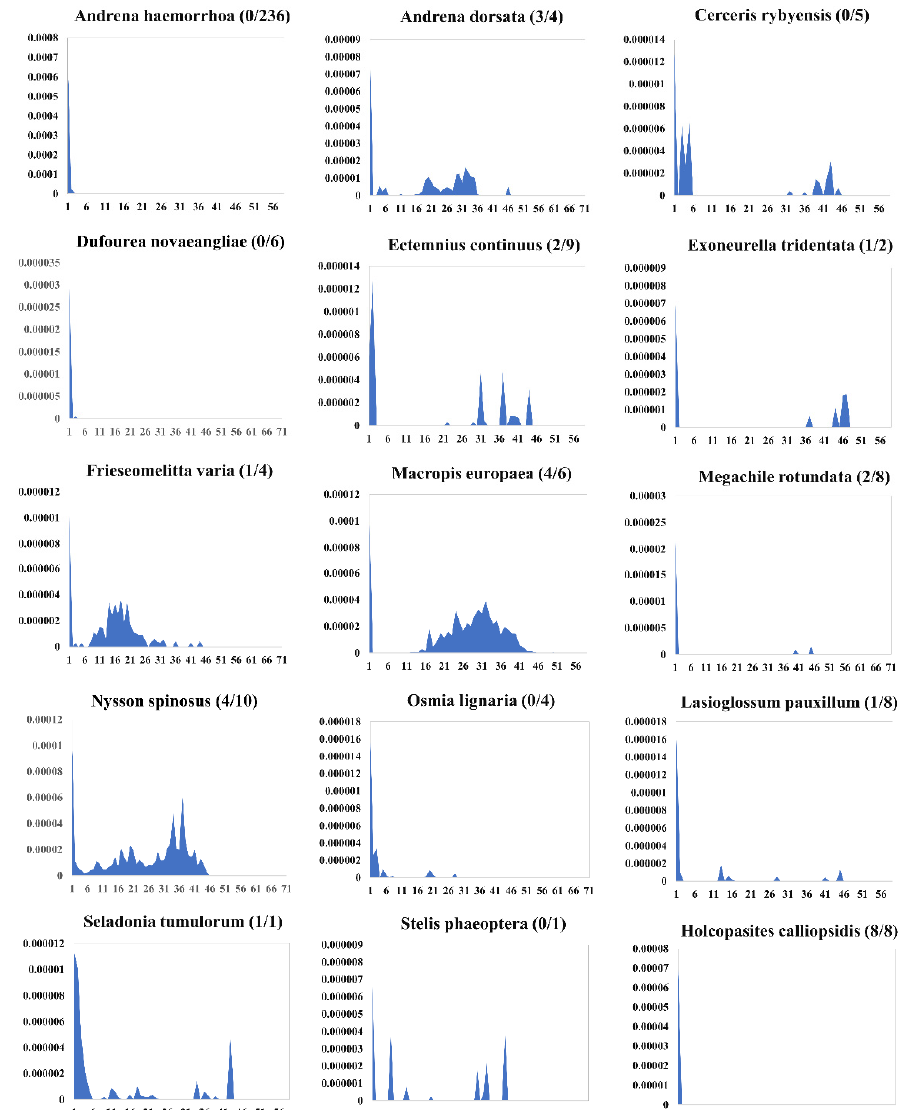
Figure 7. Evolutionary dynamics of piggyBac ( PB ) in Apoidea. The y-axis represents each PB transposon’s coverage (%) in the genome, and the x-axis indicates the K divergence estimate (%). In contrast, the numbers in brackets represent the intact copy number and total copy number of PB transposon in each genome. The figure only shows species with low K values. At the top of each chart are species names. More information is displayed in Figure S3.